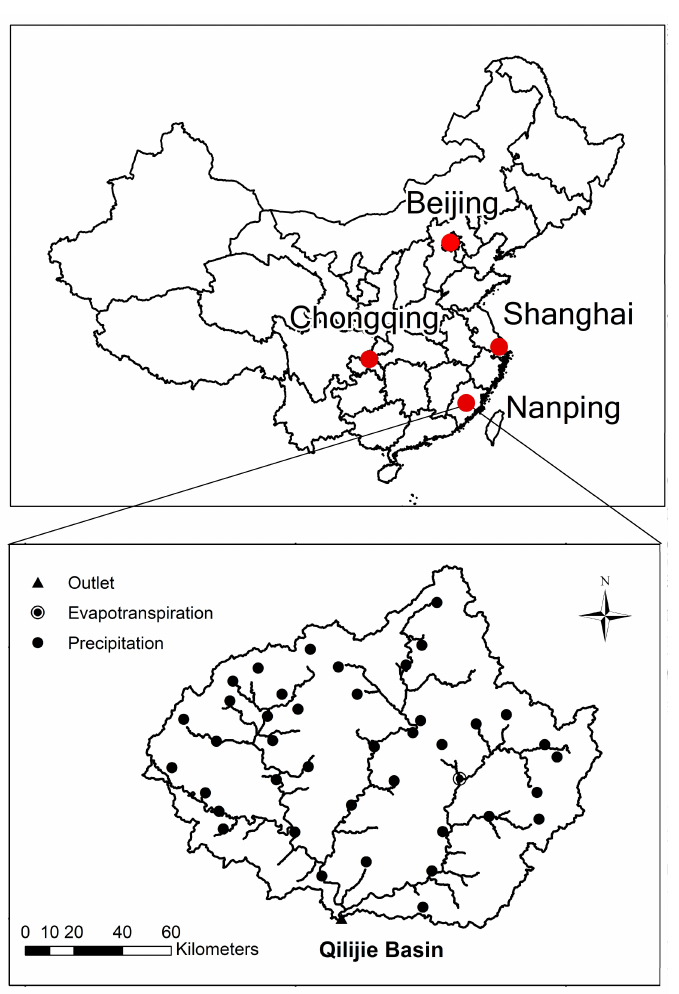
Figure 4. Map depicting the location of Qilijie Basin and the